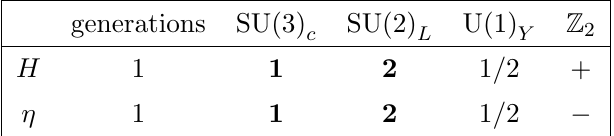
Table 4 . IDM scalar sector, containing the standard Higgs doublet H as well as a second inert doublet (cid:17) charged under the Z 2